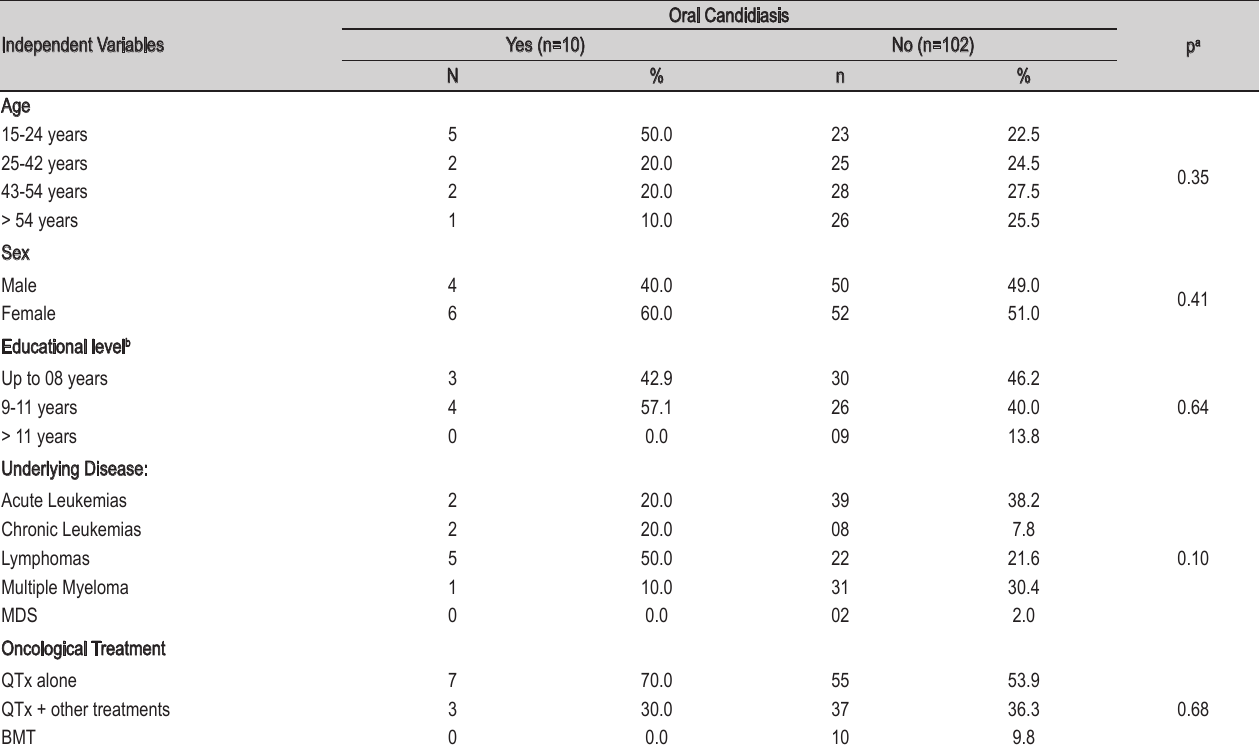
Table 2 - Association between oral candidiasis and age, sex, educational level, underlying disease and oncological treatment instituted in onco-hematologic individuals of HUPES/UFBA, Salvador, Brazil, 2013-2016.